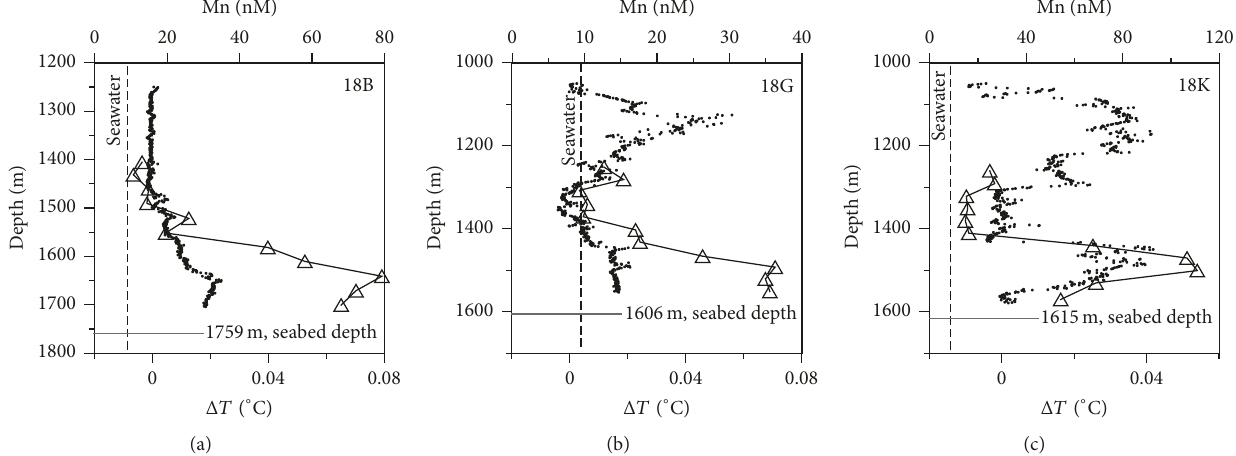
Figure 2: Vertical profiles of temperature and Mn at Stations 18B (a), 18G (b), and 18K (c). “ ⋅ ” denotes the temperature anomaly, and “ Δ ” denotes the concentration of Mn in the water column samples. The dashed line represents the value of ambient seawater (Mn data (9.30 nM) are the minimum Mn content of the three water column samples) and that of temperature. The seabed depths at Stations 18B, 18G, and 18K are 1759 m, 1606m, and 1615m, respectively.